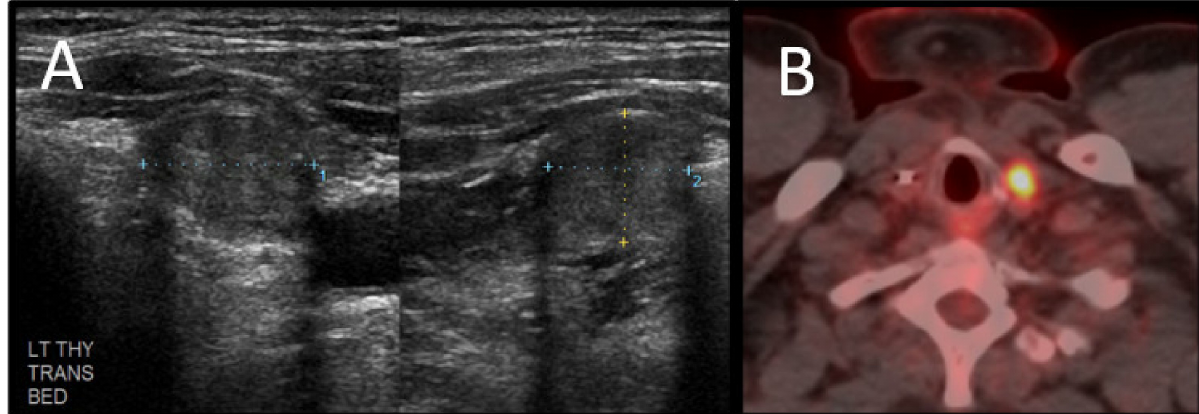
Figure 7. A 43-year-old man with a history of Cowden syndrome and follicular thyroid cancer diagnosed at age 30. The patient underwent thyroidectomy at diagnosis. He subsequently was diagnosed with primary lung cancer and was found to have a nodule in the resection bed on routine surveillance. ( A ) Grayscale ultrasound demonstrates a well- circumscribed nodule involving the left thyroid resection bed suggestive of recurrence. ( B ) Nodule shows increased FDG uptake on positron emission tomography/computed tomography. The nodule was biopsied and found to represent follicular thyroid